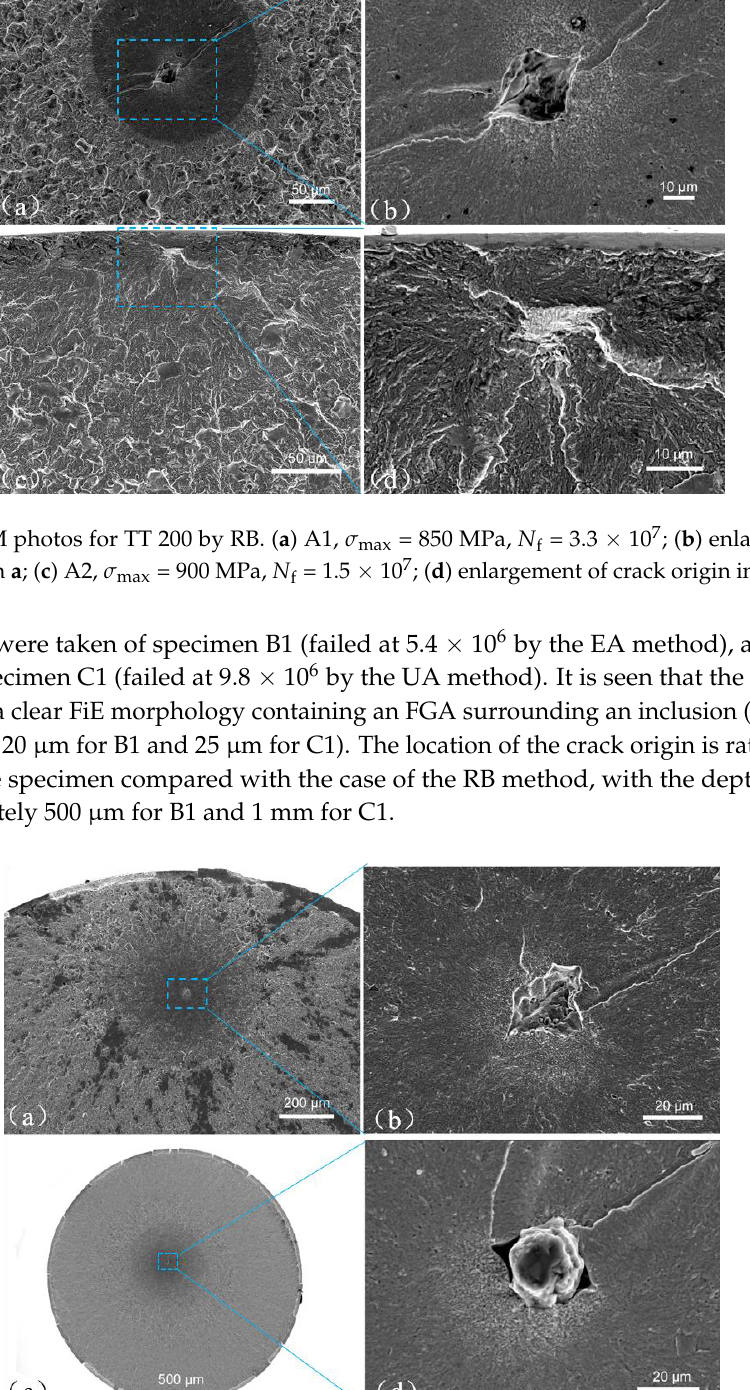
Figure 4. SEM photos for TT 200. ( a ) EA, B1, σ max = 850 MPa, N f = 5.4 × 10 6 ; ( b ) enlargement of crack origin in a ; ( c ) UA, C1, σ max = 814 MPa, N f = 9.8 × 10 6 ; ( d ) enlargement of crack origin in c .